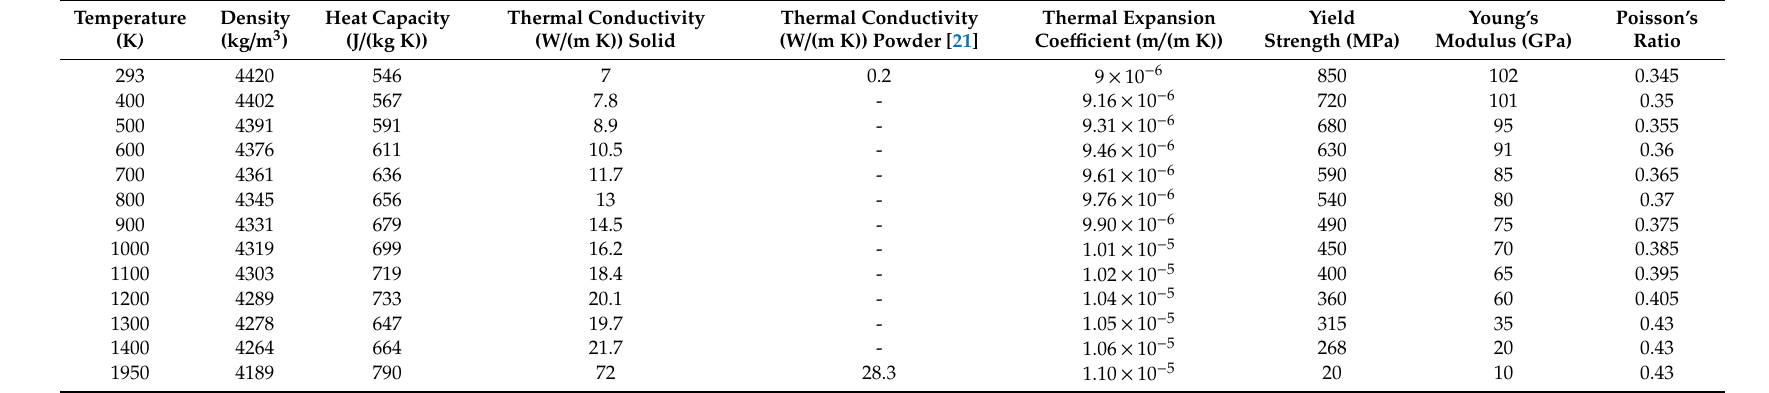
Table 2. Material properties for Ti-6Al-4V